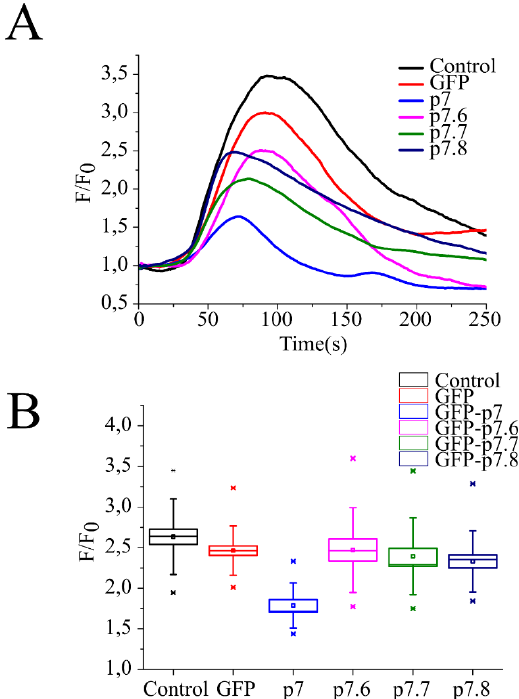
Figure 3. Effect of native and mutated forms of p7 in thapsigargin-induced calcium release from the endoplasmic reticulum. ( A ) Kinetic traces of Ca 2+ efflux from the ER into the cytosol in cells transfected with GFP or the GFP fusions as indicated in the panel. ( B ) Maximal extents of rhod-2/AM intensity change upon thapsigargin addition.